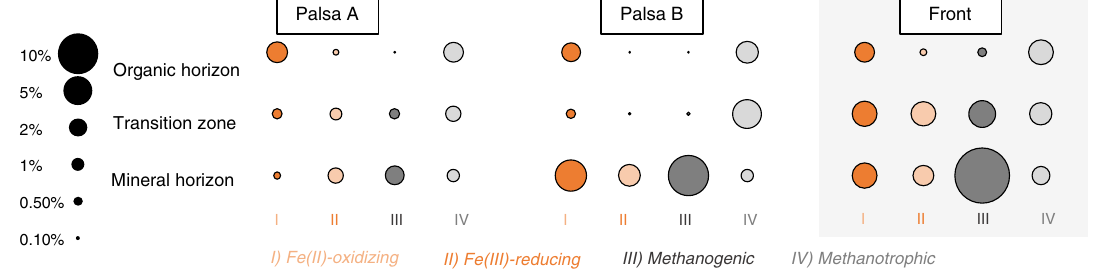
Fig. 1 Microbial iron-cycling and carbon release as dissolved organic carbon (DOC), carbon dioxide and methane emissions along a palsa hillslope. a Carbon dioxide and methane emissions along the palsa hillslope with highest emissions at the collapsing front. The reported values and error bars represent the average and standard deviation of measurements collected on three days at three separate time points in June/July 2019. b Aqueous iron (Fe 2 + ) and DOC pulse along the palsa hillslope in the transition zone (interface between organic and mineral horizon, 30 cm depth) with highest values at the collapsing front. Reported values and error bars represent the average and standard deviation of eight palsa to bog hillslopes sampled in June/July 2019. Suprapermafrost water was analyzed in the deeper mineral horizons and cannot explain the pulse of aqueous Fe 2 + and DOC at the collapsing front (Supplementary Fig. S6). c Relative 16S rRNA gene abundance of iron- and methane-cycling strains along the palsa hillslope with highest abundances at the collapsing front: I) Fe(II)-oxidizing, II) Fe(III)-reducing, III) methanogenic and IV) methanotrophic. Small letters above data mean signi fi cant differences ( P < 0.05, one-way ANOVA: TukeyHSD